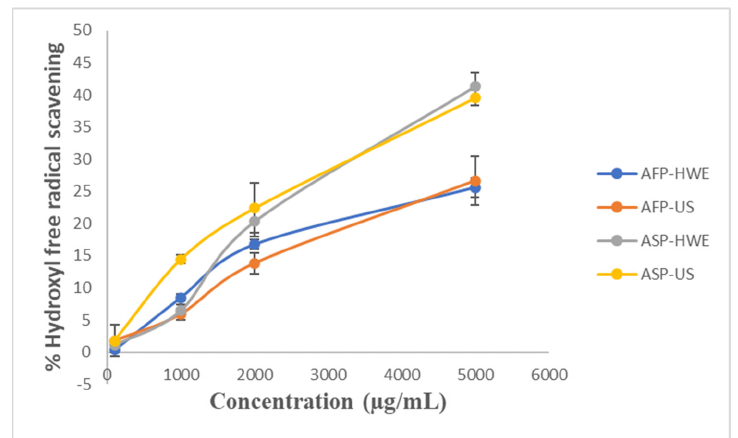
Figure 6. Hydroxyl free radical scavenging ability of polysaccharides extracted from Ajwa seed and flesh. Results are presented as means ± standard deviations ( n = 3). Differences are statistically sig- nificant if p < 0.05 when compared to the control.